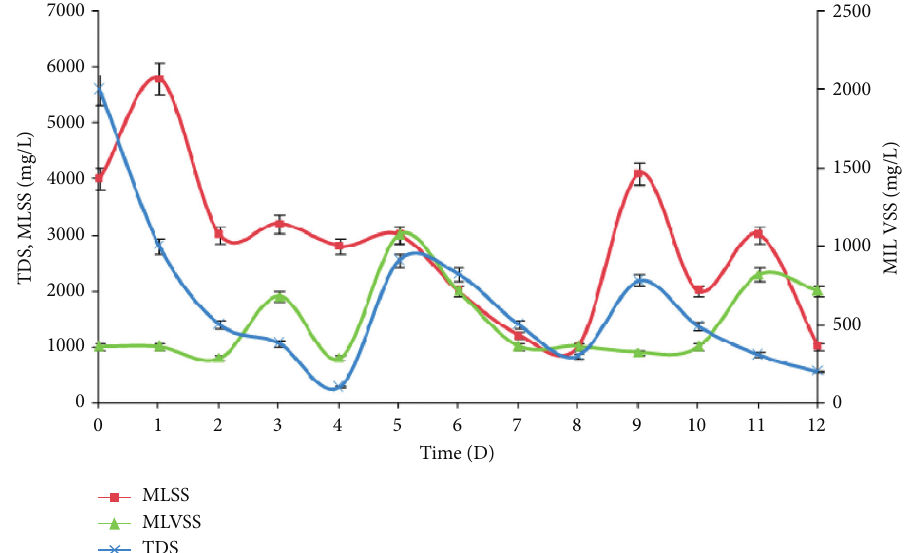
Figure 4: Removal of TDS, MLSS, and MLVSS in the anaerobic treatment of synthetic textile effluent containing 100mg/L of mixed azo dyes in An-SBR.